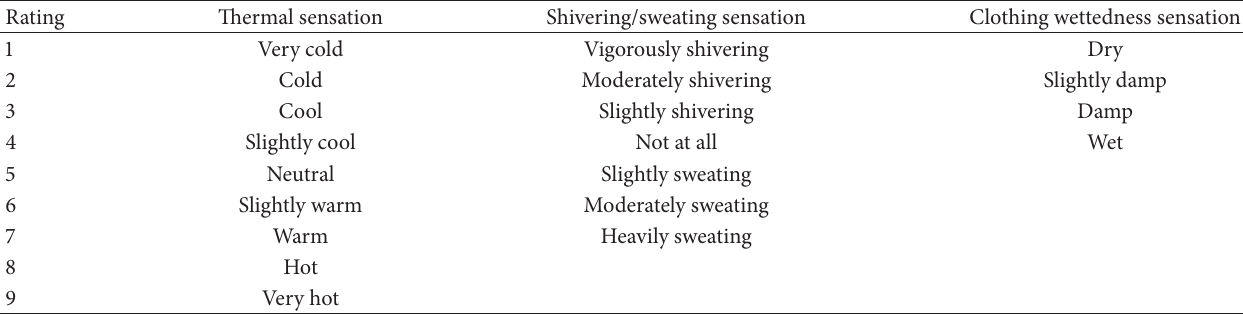
Table 2: Scales used for rating of perception (modified from [30]).